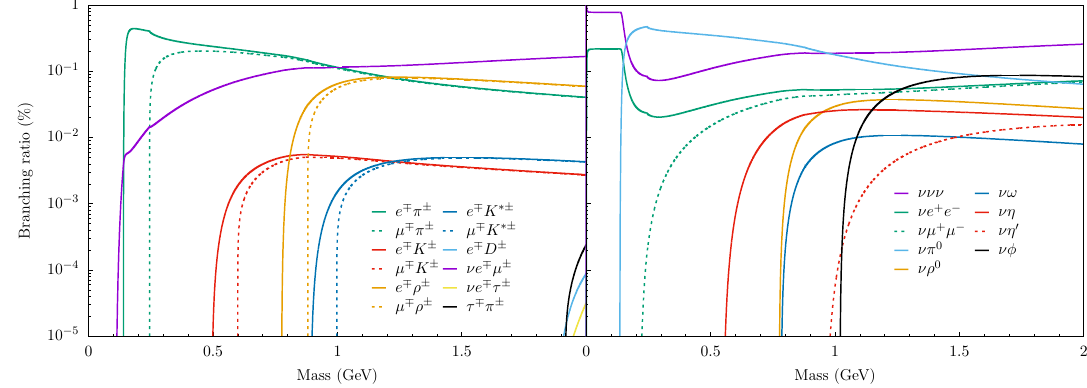
Figure 1 . The branching ratios for HNL decays, integrated over the angular variables, are shown above as functions of the mass. They are grouped in CC-mediated decays (left) and NC-mediated decays (right), in the range from 0.01 MeV up to the maximum mass limit for neutrino production, near 2 GeV. A scenario in which j U eN j 2 = j U (cid:22)N j 2 = j U (cid:28)N j 2 is chosen here for illustrative